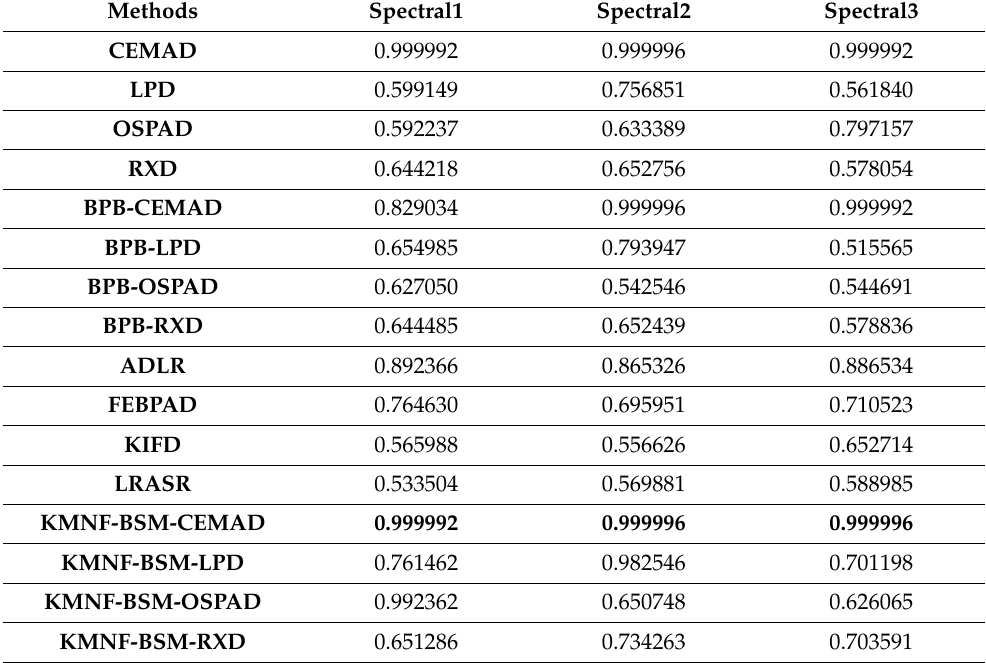
Table 5. The AUC ( D,F ) values of HSIs with different spectral